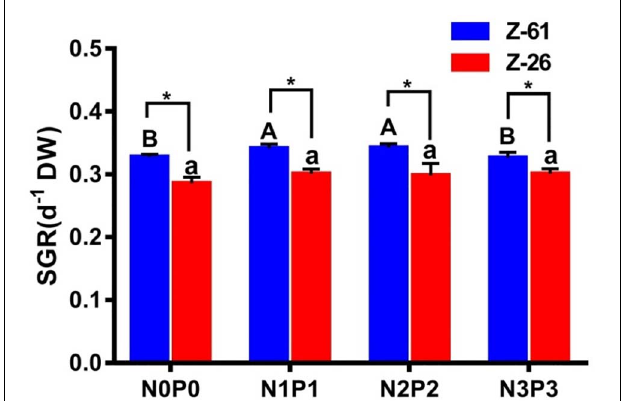
FIGURE 1 | The specific growth rates (SGR) of Z-61 (blue bars) and Z-26 (red bars) cultured under four different nutrient conditions. Different letters represent significant differences ( P < 0.05) among the treatments (lowercase for Z-26 and capitalized for Z-61). “*” above the bars indicates significant difference between Z-61 and Z-26. Values are means ± SD ( n = 4). DW: dry